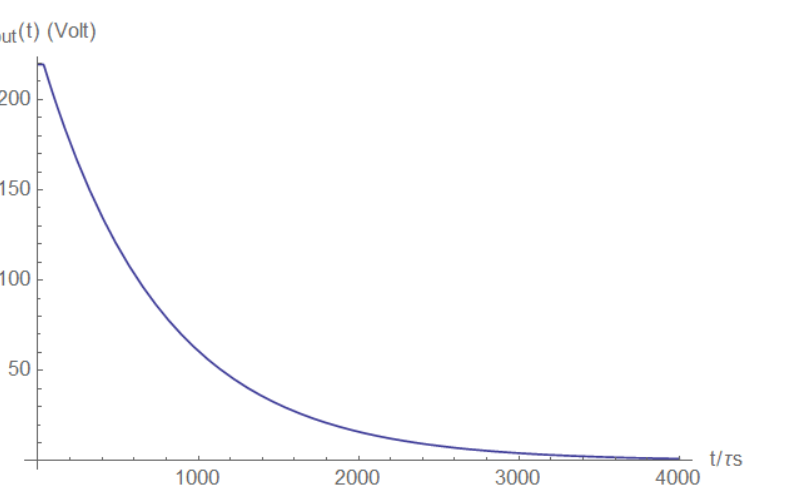
Figure A34. Load voltage (right after the short).